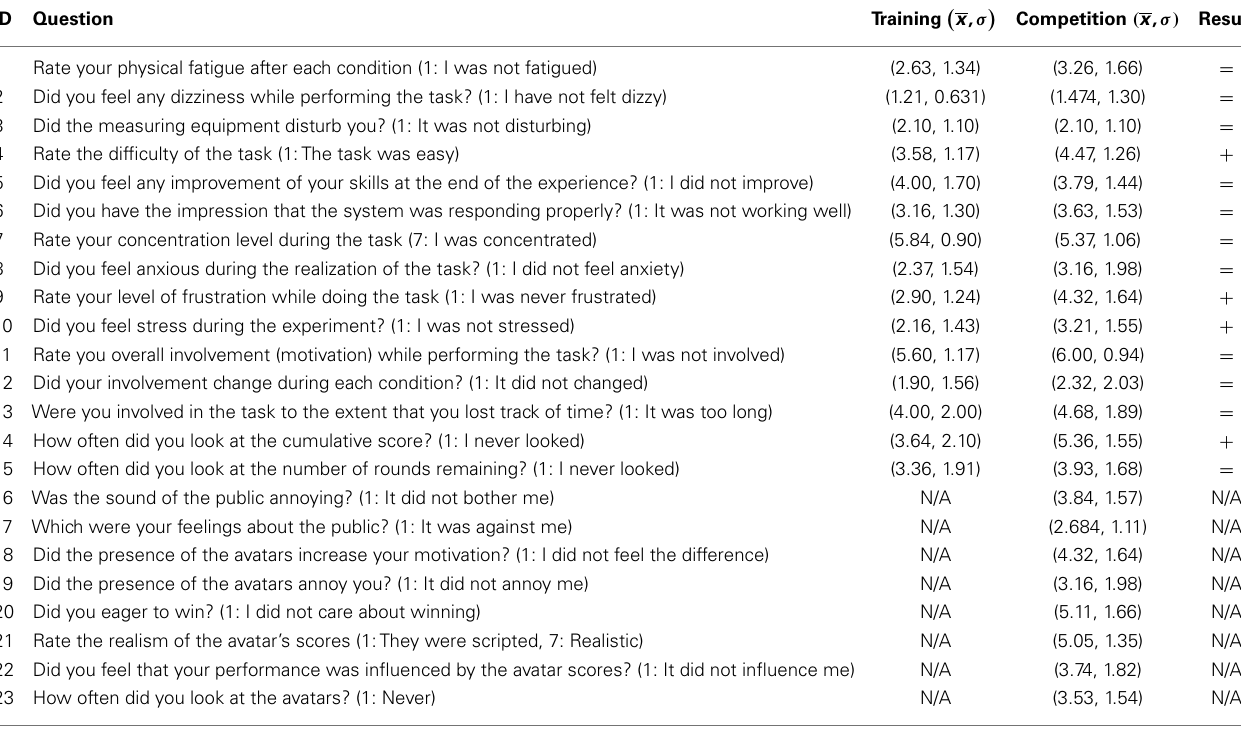
Table 2 | Summary of the user questionnaire and the statistical analysis of the subjective responses (7-likert scale)